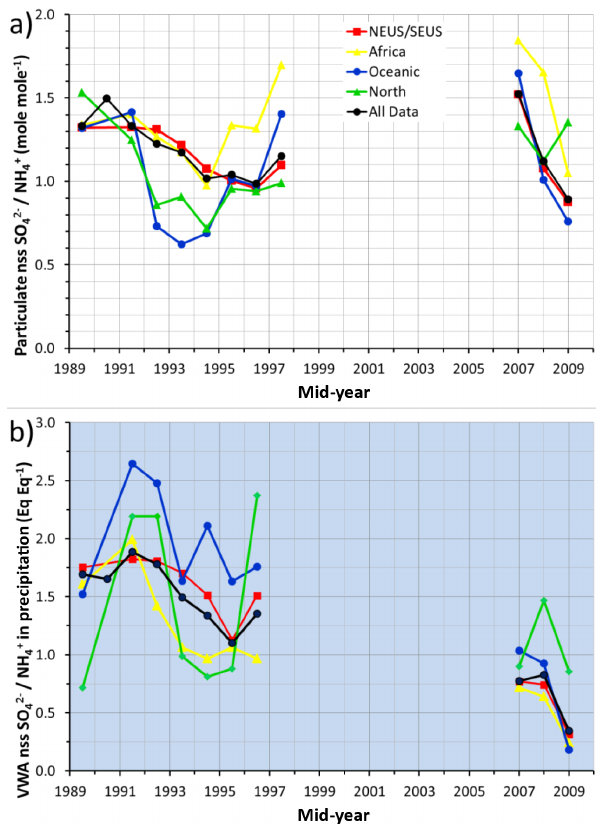
Figure 5. Temporal trends in (a) ratios of annual mean concentra- tions of particulate nss SO 2 − versus NH + (white backgrounds) and 4 4 (b) corresponding ratios of annual VWA concentrations in precipi- tation (light-blue backgrounds) associated with NEUS/SEUS (red), African (yellow), Oceanic (blue), and North (green) flow regimes and for all data